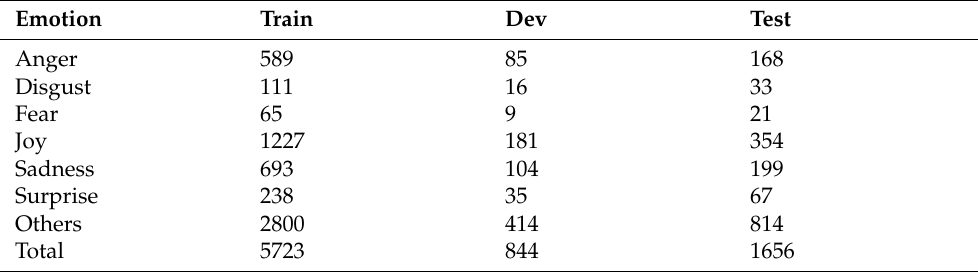
Table 1. Number of tweets per category in the EmoEvent